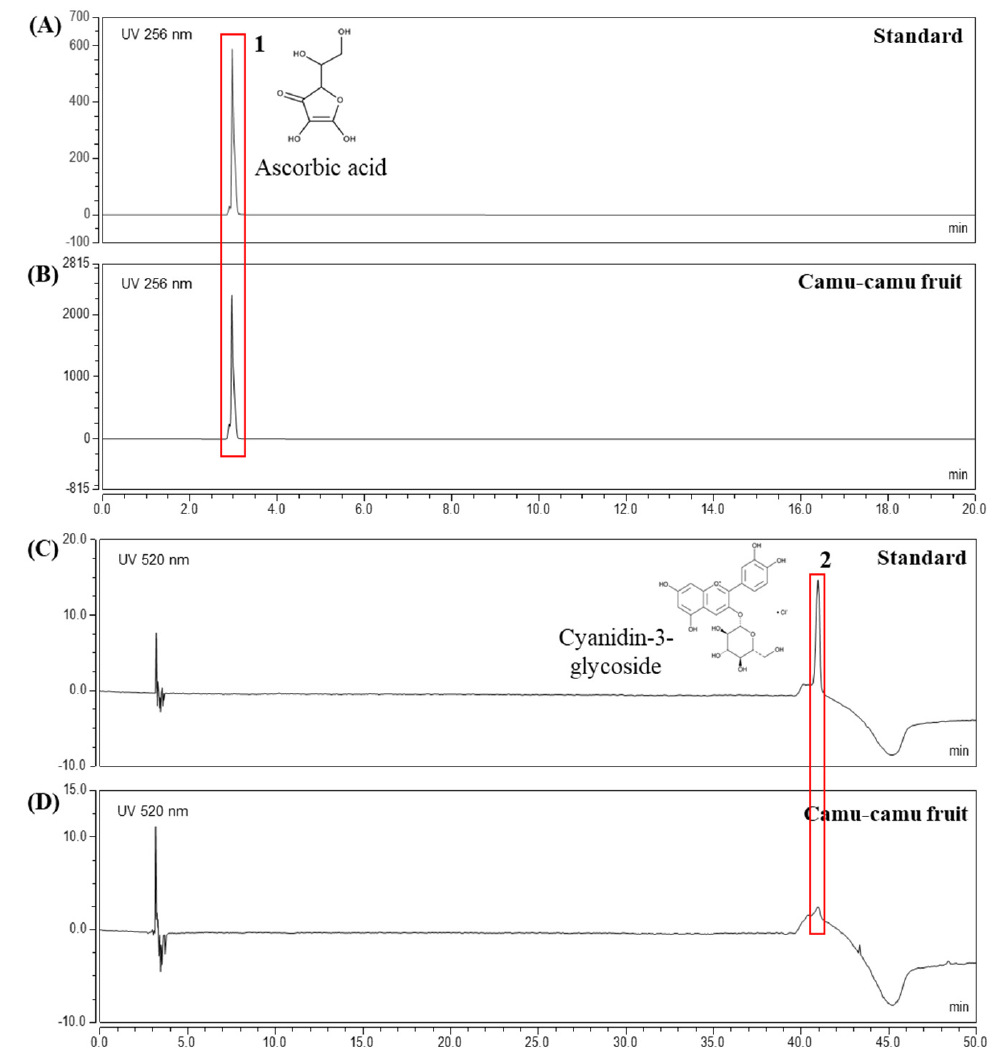
Figure 1. HPLC analysis of ascorbic acid standard ( A ), cyanidin-3-glycoside standard ( C ), and camu-camu fruit extract ( B , D ).